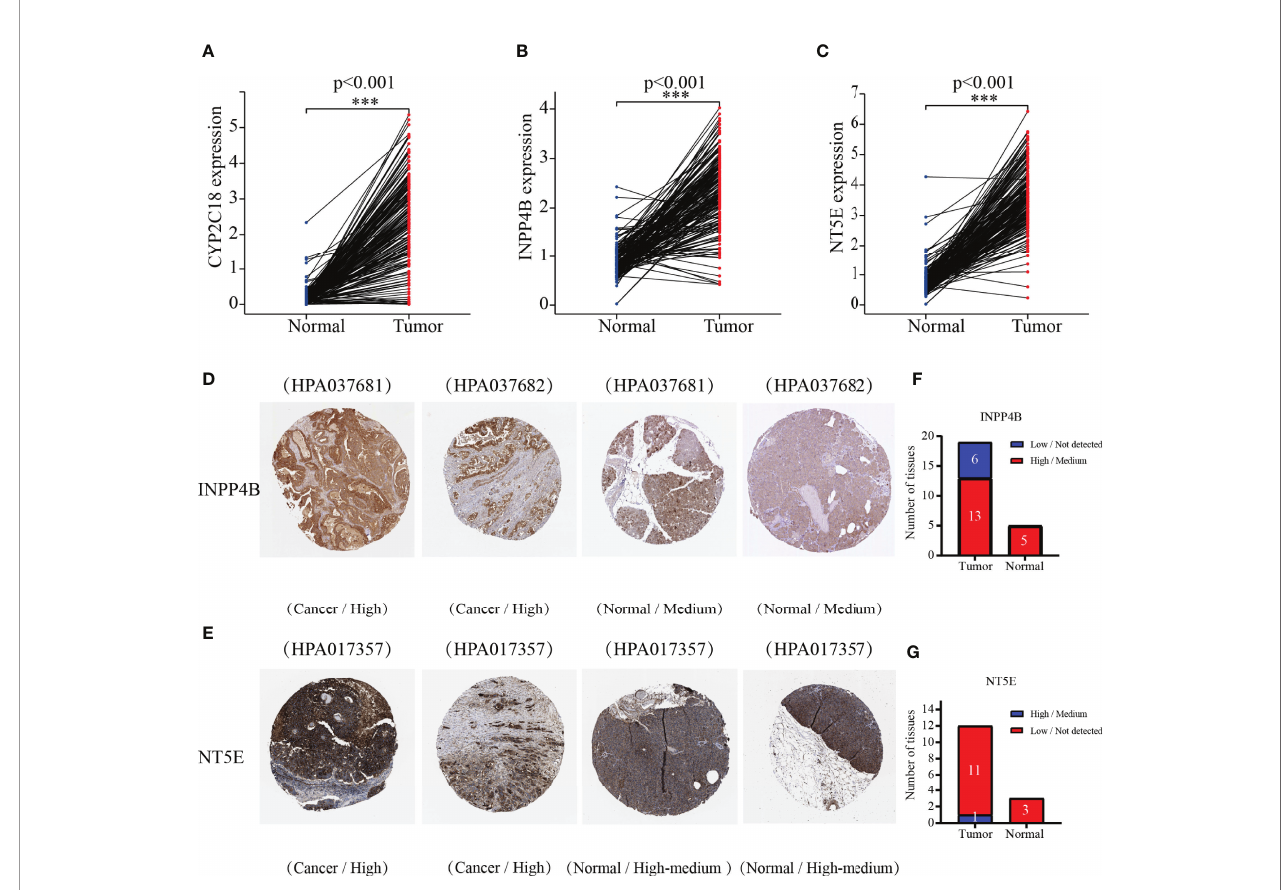
FIGURE 7 | Comparing the 3-MRG mRNA levels in PC and normal pancreas tissues. (A – C) CYP2C18, INPP4B, and NT5E. Verifying the 3-MRG expression in PC with normal tissues on the HPA database. Information about CYP2C18 was not available. (D – G) INPP4B and